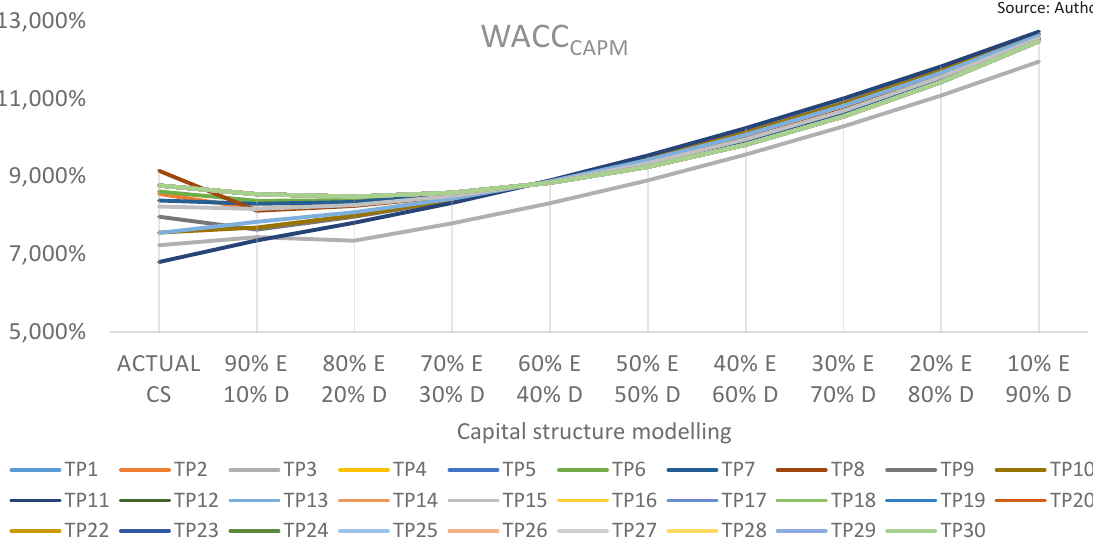
Figure 2. Development of weighted average capital cost following the change in capital structure